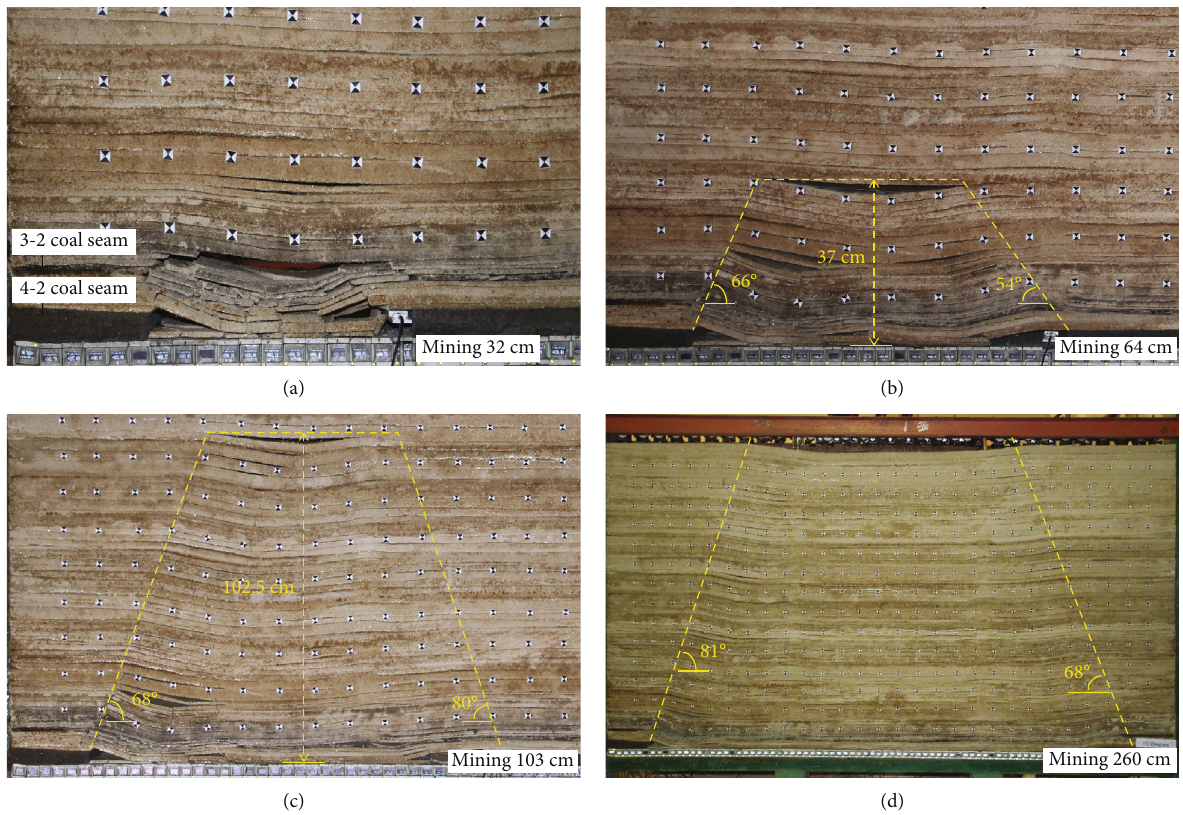
Figure 12: The 222 working face is opened until the end of mining. (a) The 222 working face for the fi rst weighting. (b) The 222 working face for the 8 th weighting. (c) The 222 working face for the 22 nd weighting. (d) End of mining in the 222 working